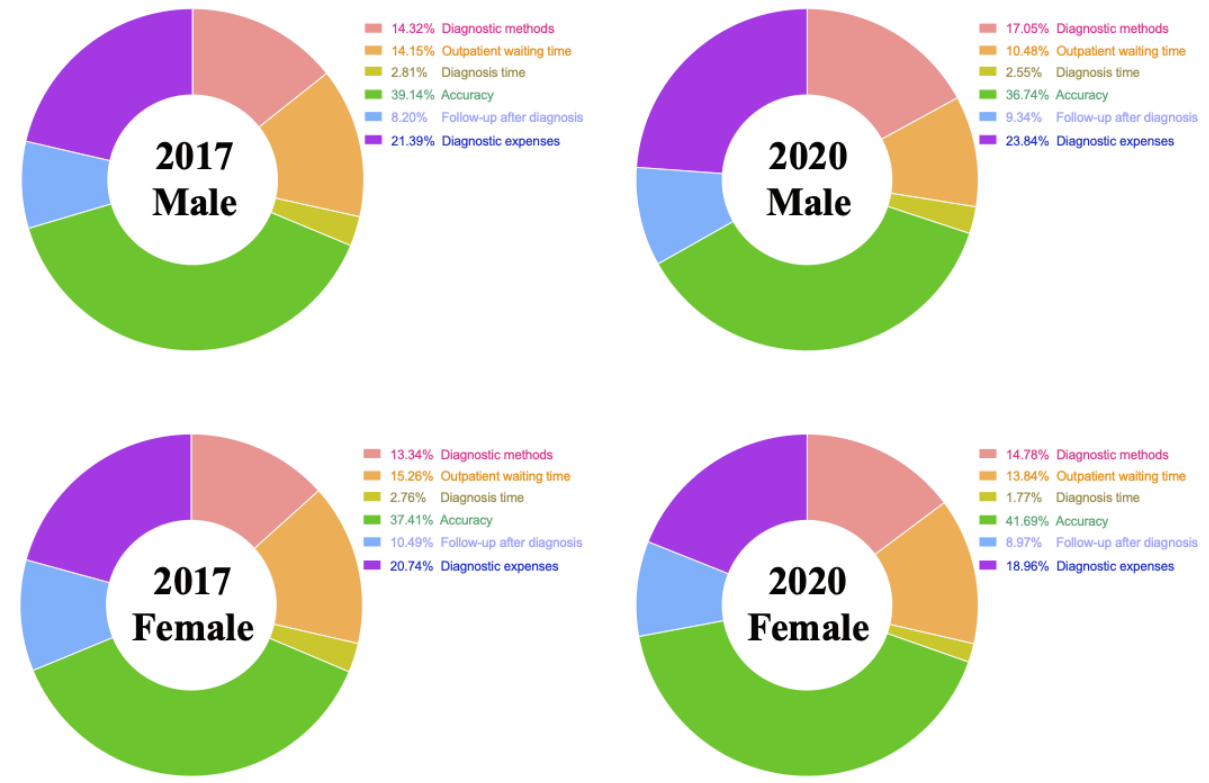
Figure 5. Weighted importance of diagnosis attributes in 2017 and 2020, as determined by the latent class model, which stratified data according to sex (ie, male and female